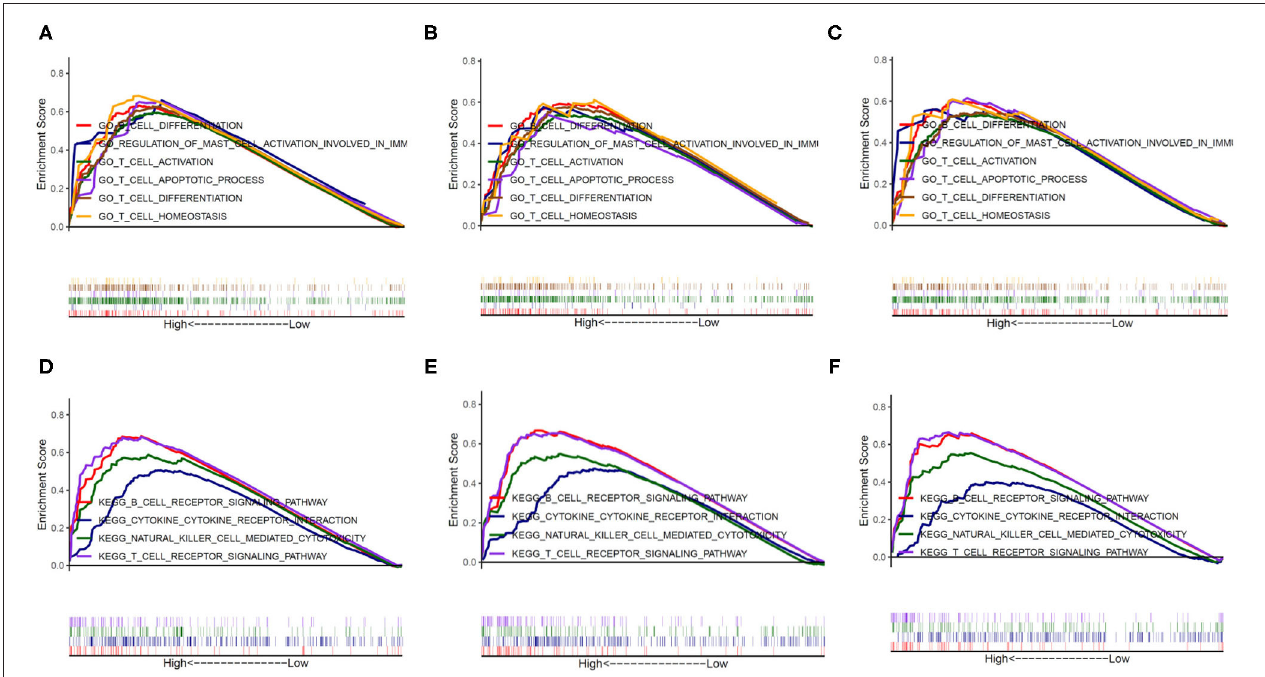
FIGURE 6 | The potential function of PERK analyzed by GESA. The genes of PERK were mainly enriched in six GO terms in BRCA (A) , HNSC (B) , and THCA (C) and enriched in four KEGG terms in BRCA (D) , HNSC (E) , and THCA (F) .